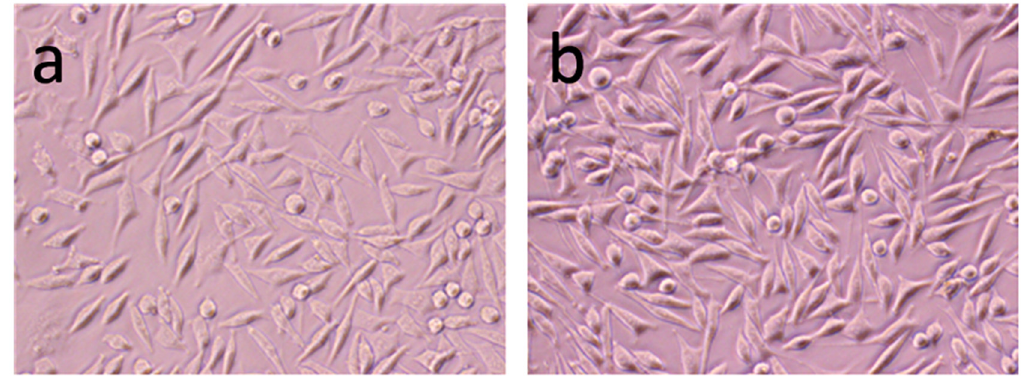
Figure 6. Cell topography of MG-63 cells co-cultured with 60 ug/mL of COS3000-1 sample for different times: ( a ) 24 h; ( b ) 72 h.